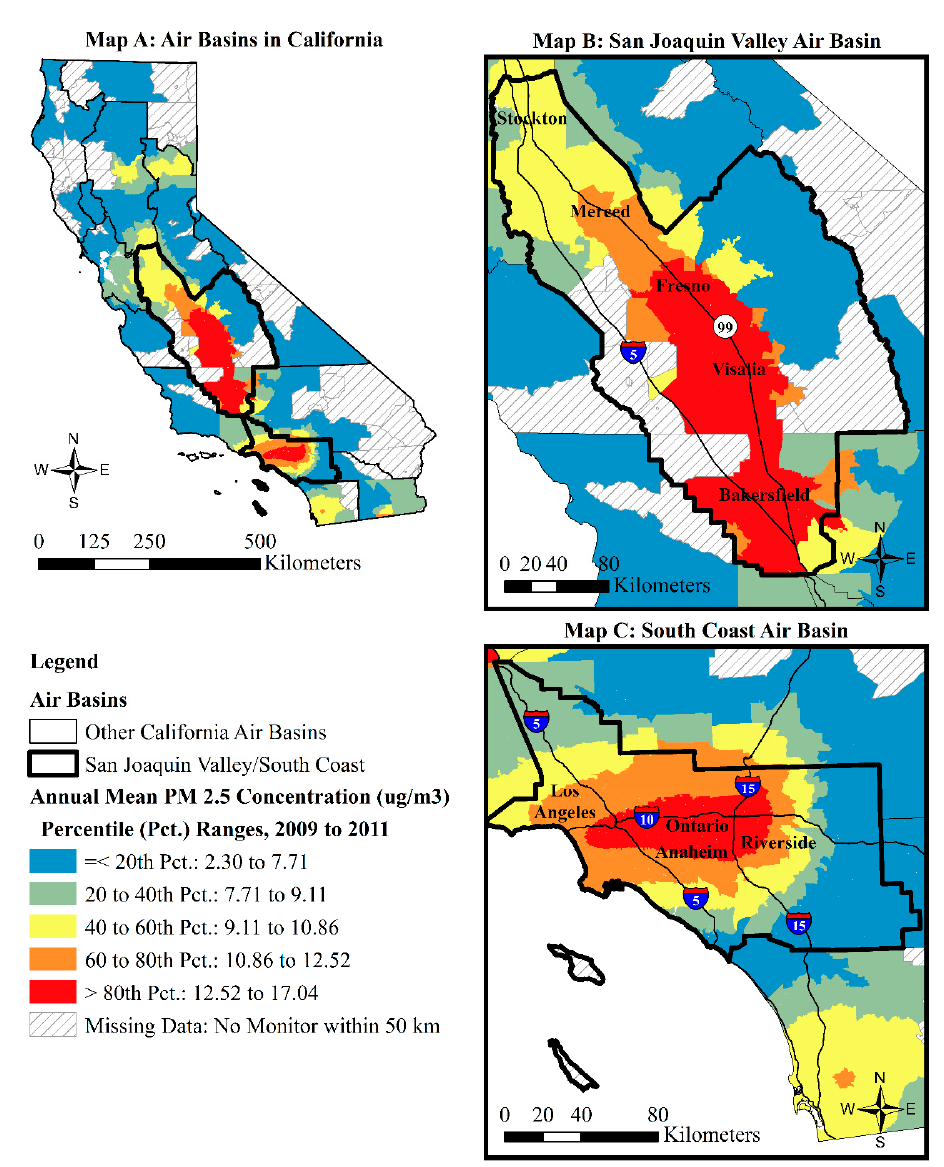
Figure 2. Percentile ranges of annual mean PM 2.5 concentrations from 2009 to 2011 in ( A ) California, ( B ) the San Joaquin Valley air basin, and ( C ) the South Coast air basin.